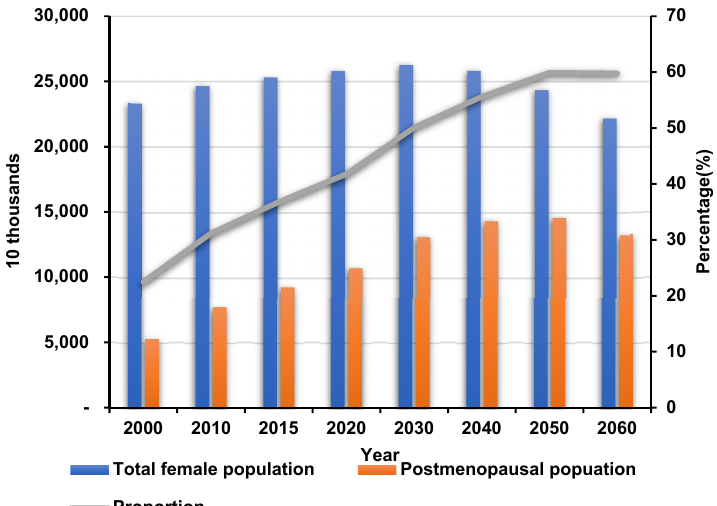
Figure 1. Transitions of the total female and postmenopausal female populations in South Korea. The total female population will peak in 2030 then decrease through to 2060. The postmenopausal female population will continuously increase. After 2030, over half of South Korean females will be postmenopausal [3].